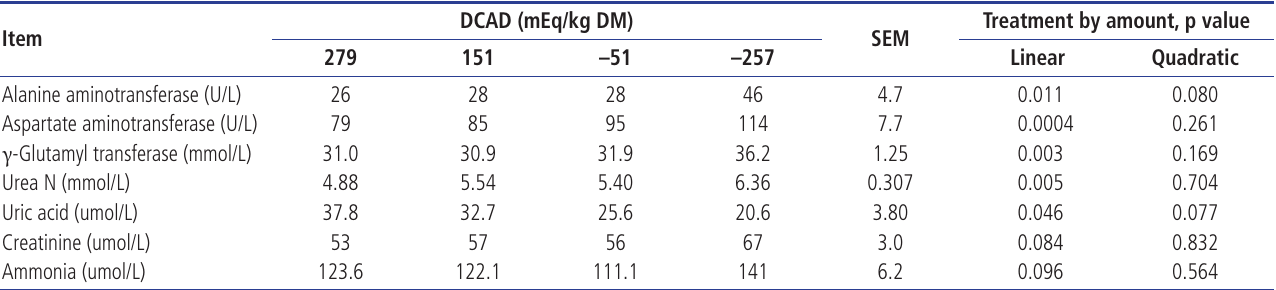
Table 5. Effects of low DCAD on biochemical indices of blood of lacating dairy